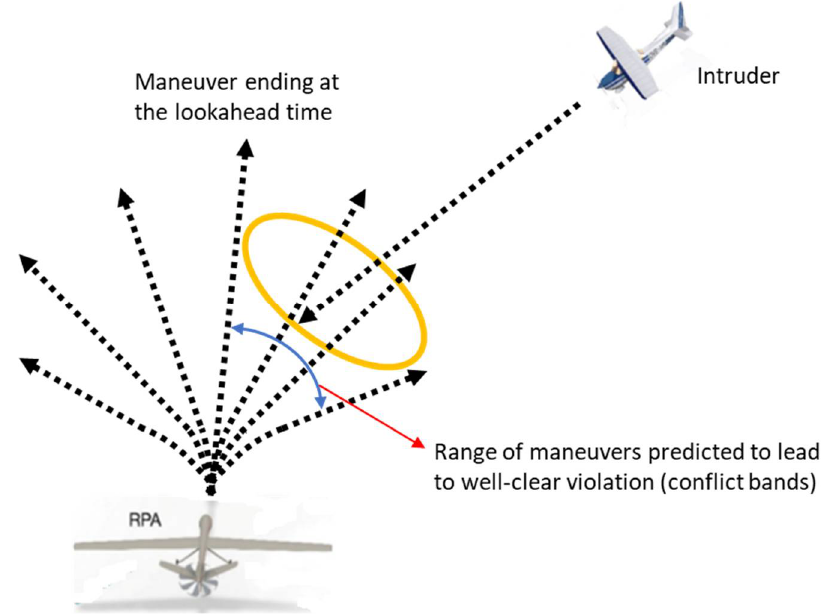
Figure 9. Aircraft state projection for the computation of the horizontal conflict bands.